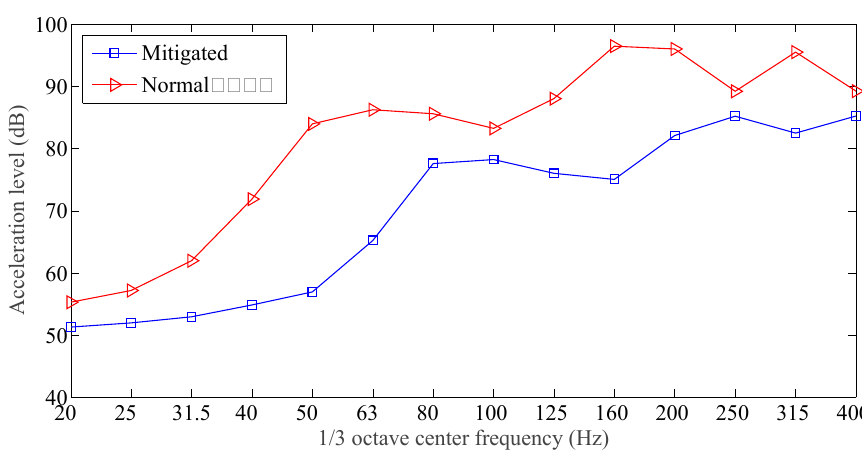
Figure 13. Acceleration spectrum for testing point 3. Table 4. The acceleration level for testing points. Measuring Points